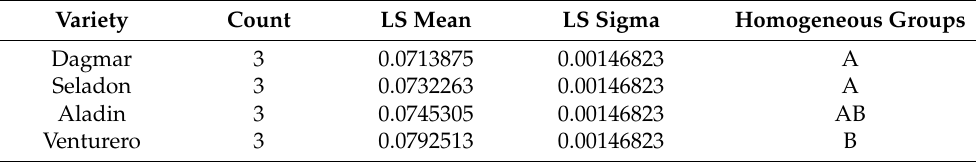
Table 3. The 95.0% LSD analysis for the Simpson